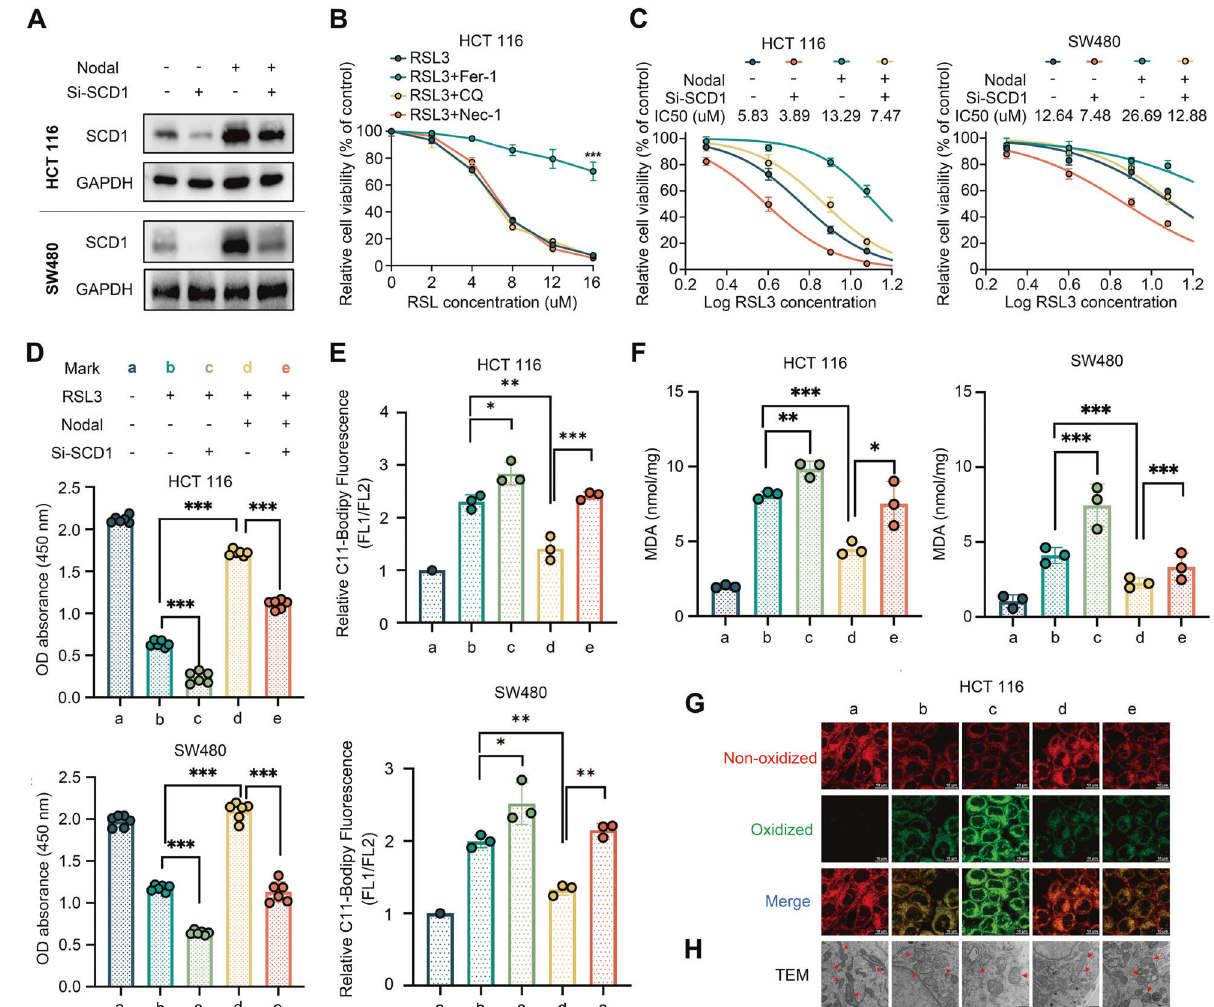
Fig. 5 Nodal regulated the sensitivity to RSL3-induced ferroptosis via SCD1. A Western blotting of SCD1 in HCT116 and SW480 cells in the vector and oe-Nodal groups with or without si-SCD1 transfection. B Relative cell viability of HCT116 cells treated with different concentrations of RSL3 (a ferroptosis inducer) for 48 h with or without several cell death inhibitors. C Relative cell viability of HCT116 and SW480 cells in the vector and oe-Nodal groups with or without si-SCD1 transfection. The cells were treated with different concentrations of RSL3 for 48 h. D Cell viability was measured via CCK8 assay in HCT116 and SW480 cells in the vector and oe-Nodal groups with or without si-SCD1 transfection. HCT 116 cells and SW480 cells were treated with 8 μ M and 12 μ M RSL3 for 48 h, respectively. E BODIPY ™ C11 staining analysis of lipid peroxidation via fl ow cytometry in Nodal-overexpressing HCT116 and SW480 cells with or without si-SCD1 transfection. F MDA levels in HCT116 and SW480 cells in the vector and oe-Nodal groups with or without si-SCD1 transfection. G Representative confocal laser scanning microscopic images of lipid peroxidation in HCT116 cells (green: oxidised lipids; red: non-oxidised lipids). H Representative transmission electron microscopic images of morphological changes in mitochondria of HCT116 cells (red arrows: mitochondria). ( ∗ P < 0.05, ∗∗ P < 0.01 and ∗∗∗ P <